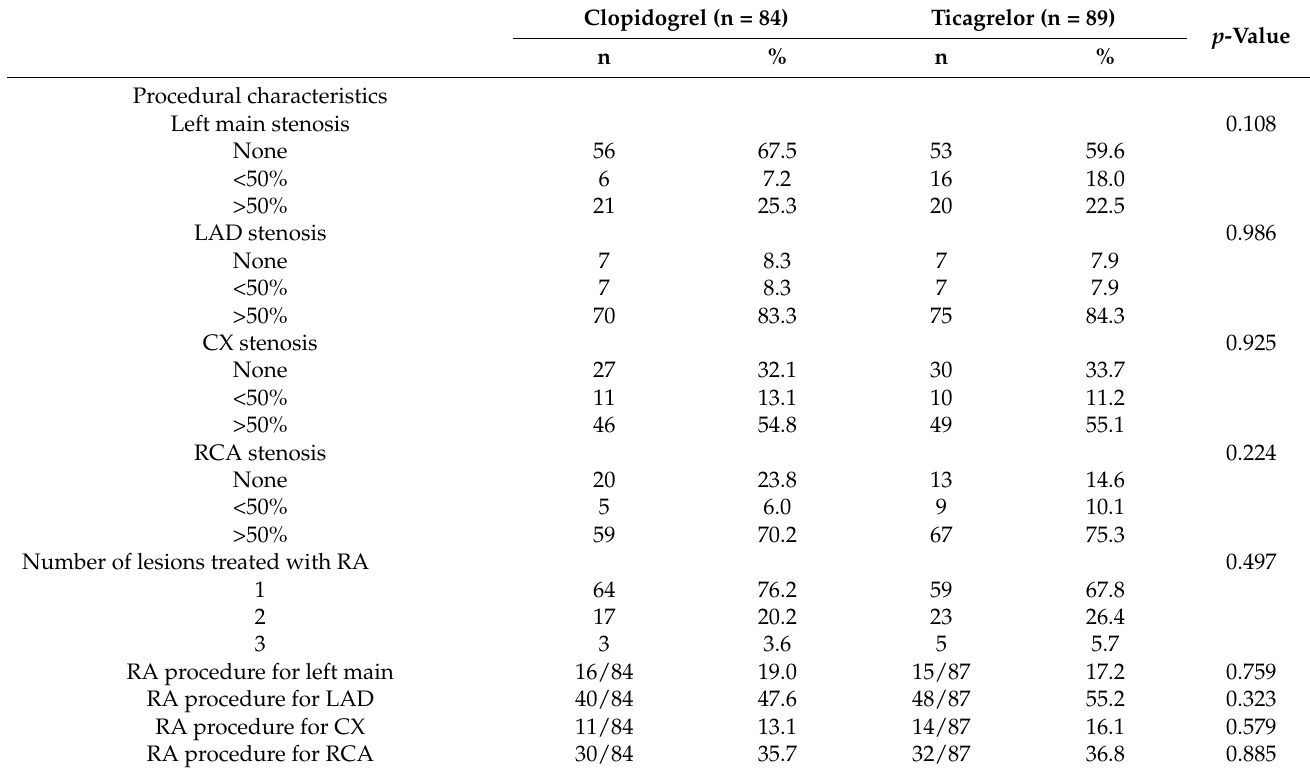
Table 2. Baseline angiographic characteristics and procedural